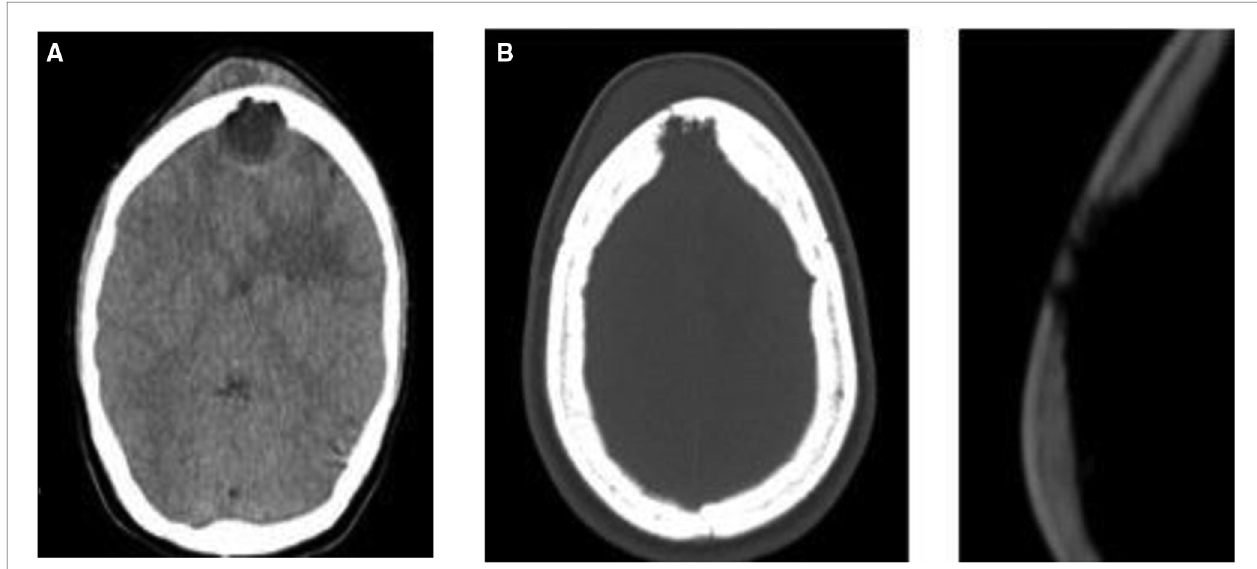
FIGURE 1 | ( A ) Cranial CT, without contrast, axial cut, evidencing subgaleal hypoattenuating formation in the frontal region, noting in the same plane, but in intracranial and extra-axial situation, hypoattenuating lesion with expansive character associated with irregularities in the contours of the inner table of the adjacent frontal bone. ( B ) bone window, in the same plane of subgaleal and extra-axial lesions, evidencing in the frontal bone, especially in the internal table lytic destruction with bone